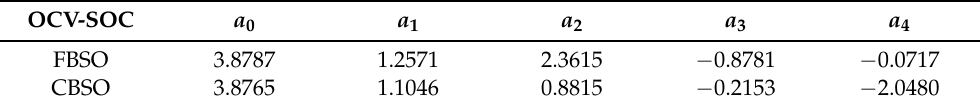
Table 1. The parameter identification results for the coefficients of OCV-SOC polynomial.